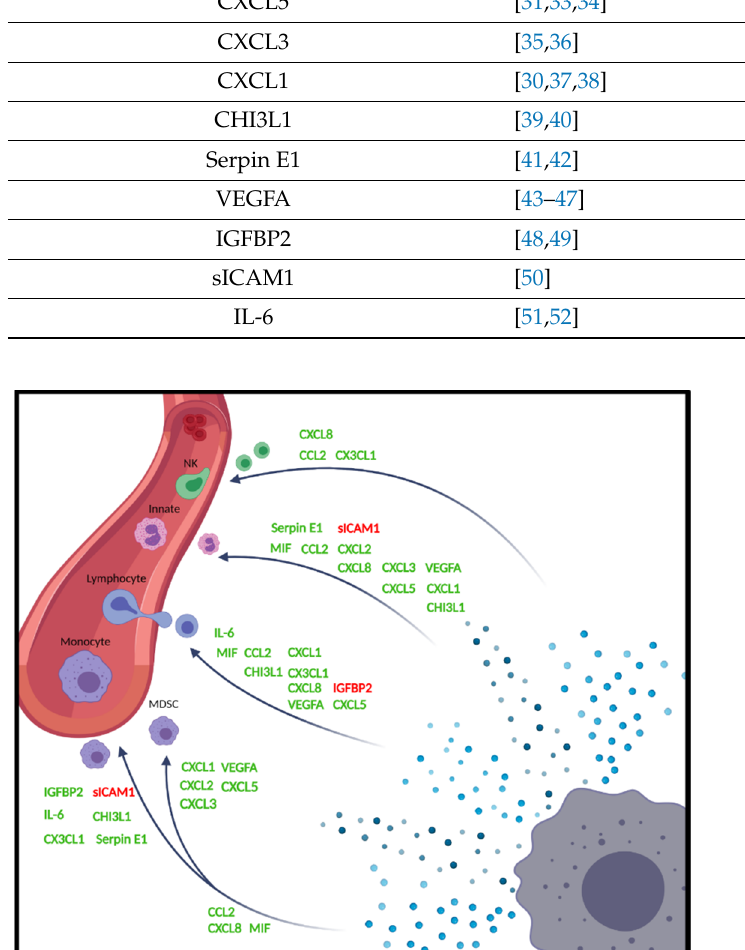
Figure 1. Secreted proteins associated with immune recruitment into tumour microenvironments. Glioblastoma cells secreted a milieu of soluble proteins into the tumour microenvironment. These soluble molecules comprise chemokines capable of acting on the blood–brain barrier to promote peripheral immune cell recruitment, cytokines that activate or suppress immune cell function and other immune modulators responsible for shaping tumour immune responses. Green = positive recruitment, red = negative recruitment. Table 1. Citations of depicted secreted proteins presented in Figure 1.